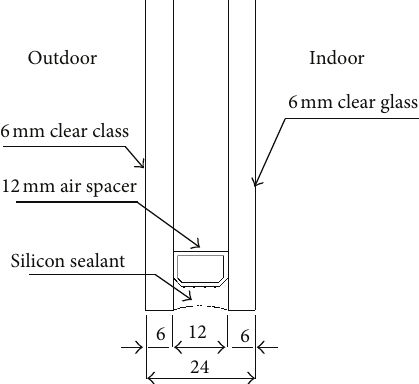
Figure 6: Composition of a typical glazing unit.